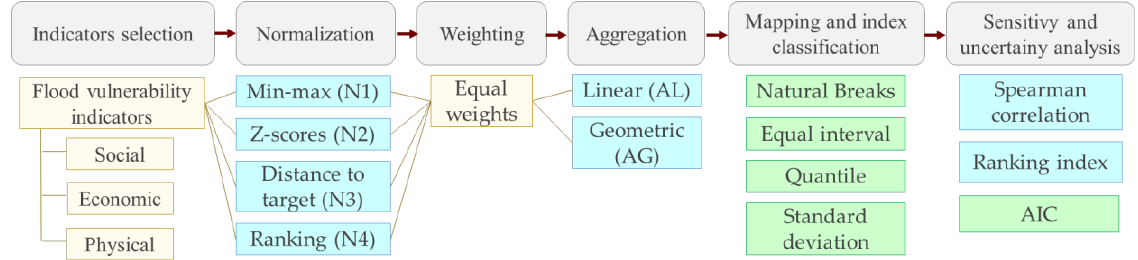
Figure 2. Flowchart with the methodological outline. The uncertainty of the different normalization and aggregation methods was evaluated using both the Spearman correlation and the ranking index analysis (blue boxes). The uncertainty coming from the index classification step was evaluated by employing the Akaike’s information criterion (AIC) analysis (green boxes).